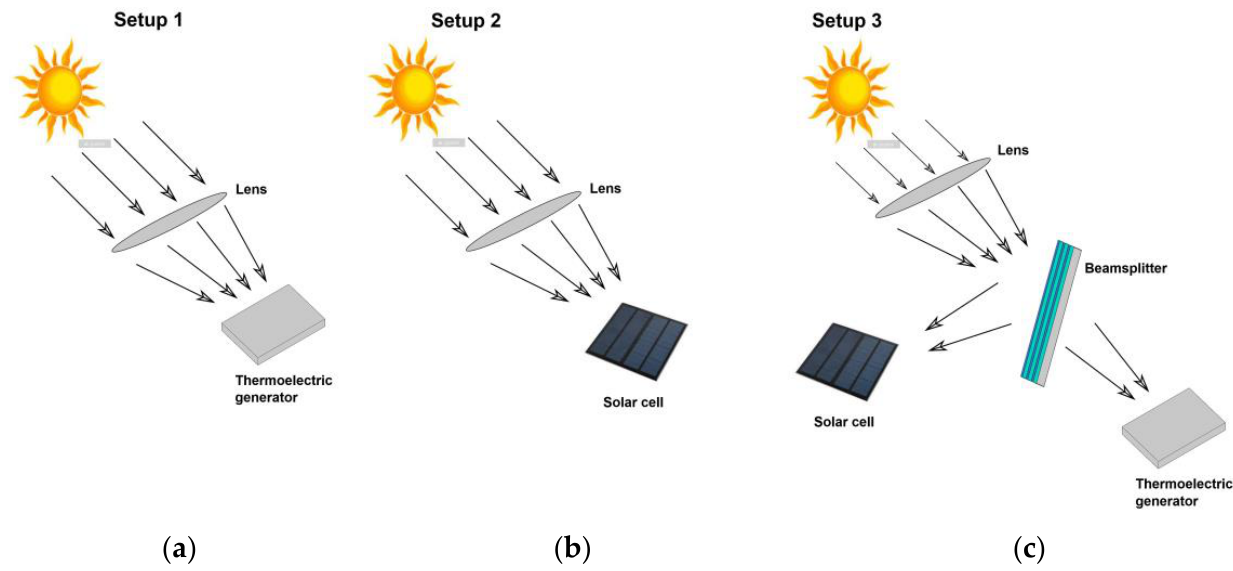
Figure 3. ( a ) TE-only system; ( b ) PV-only system; ( c ) TE-PV-BS hybrid system.